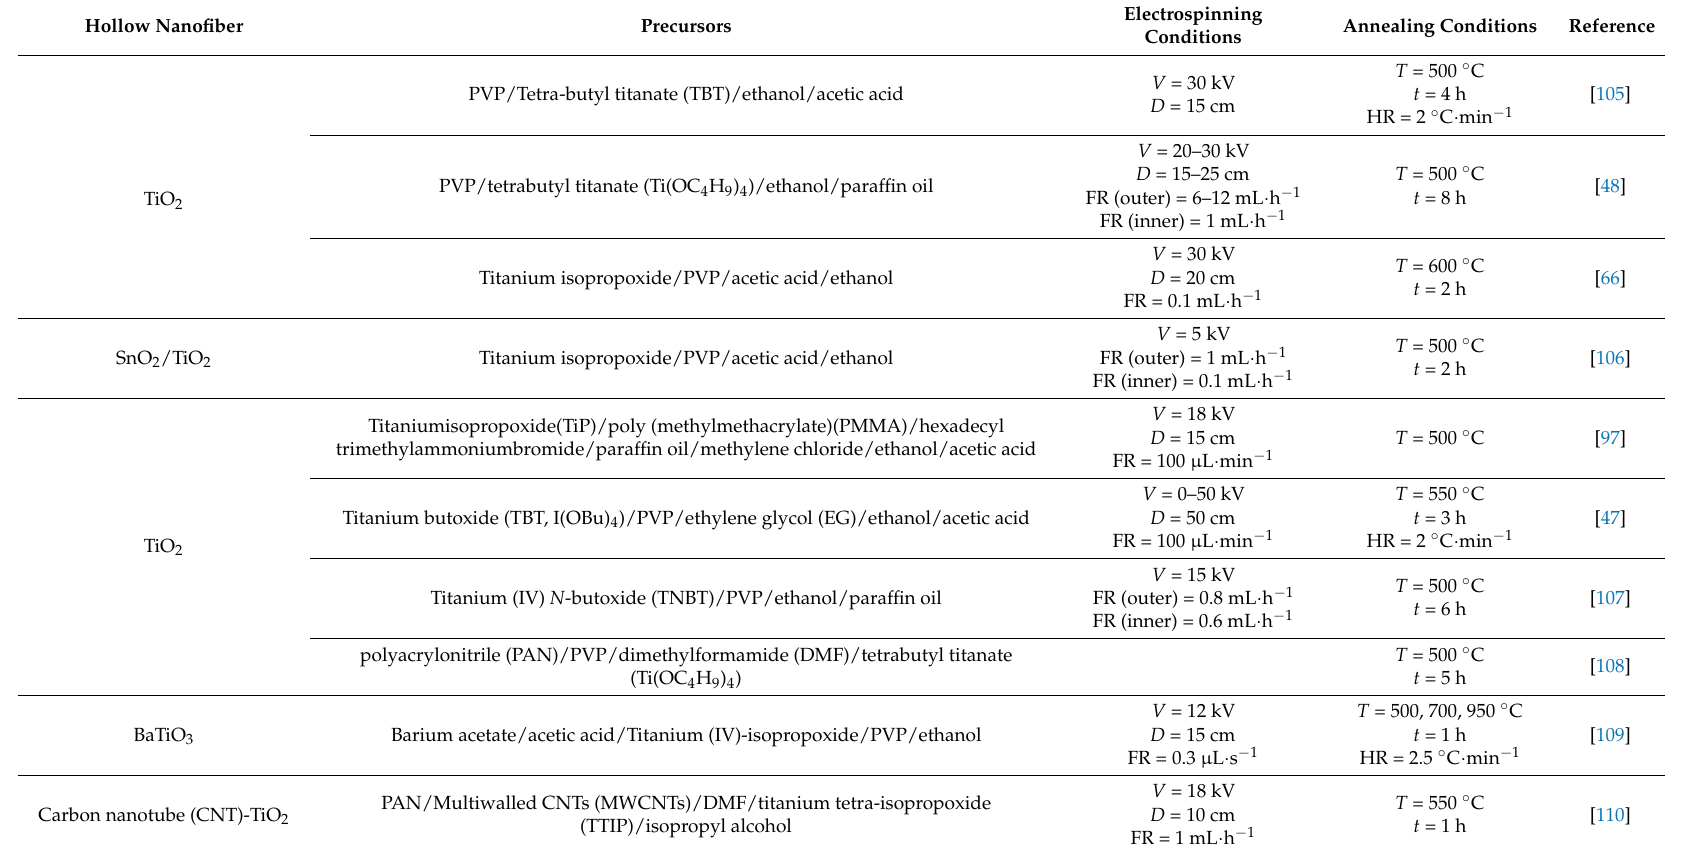
Table 2. Various metal oxide hollow nanofibers and their detailed electrospinning